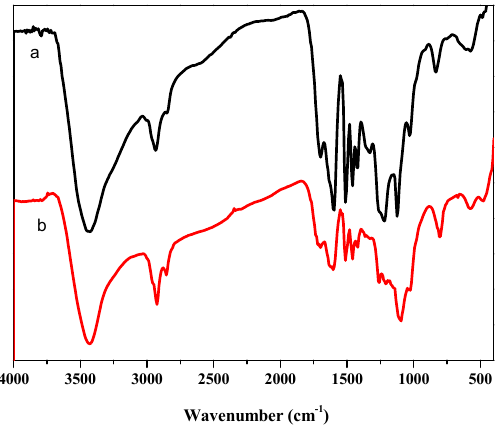
Figure 1. FTIR spectra of Lig (a) and CLig (b).